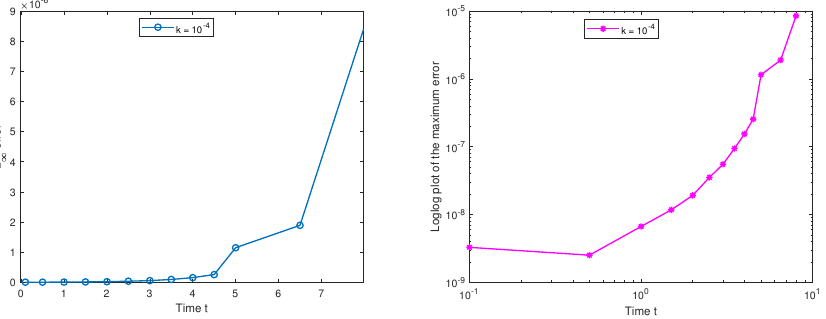
Figure 18. Plots for the maximum error vs. time t ∈ [ 0,8.0 ] and the loglog plot of the max. error vs. time using the standard FDM for Experiment 4 with ∆ x = ∆ y = 0.1 and ∆ t = 10 − 4 , respectively. Figure 19 gives the 3D plots for the numerical solution vs. x vs. y , using the classical FDM with the exact solution at times t = 1.0, 2.0, 5.0, 8.0 for Experiment 4. We can also see from Table 4 that the classical finite difference scheme performs very well for numerical Experiment 4 and that the numerical results using VHPM rapidly converge to the exact solution, as shown in Section 7.1.